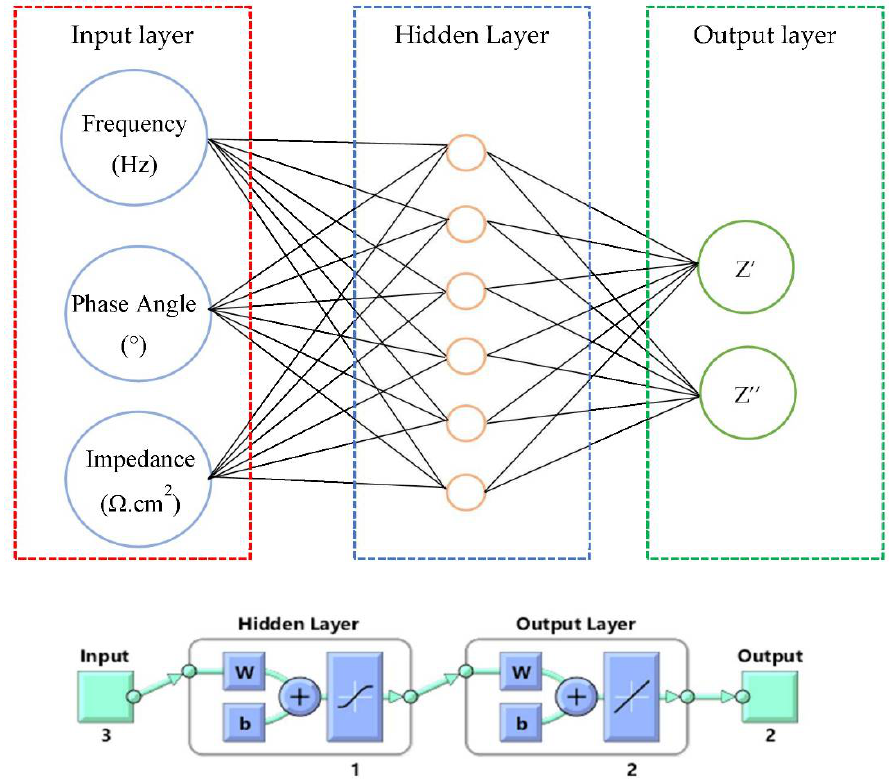
Figure 1. Artificial neural network architecture.